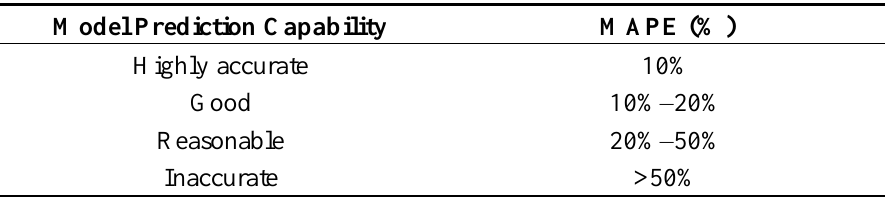
Table 13. MAPE accuracy